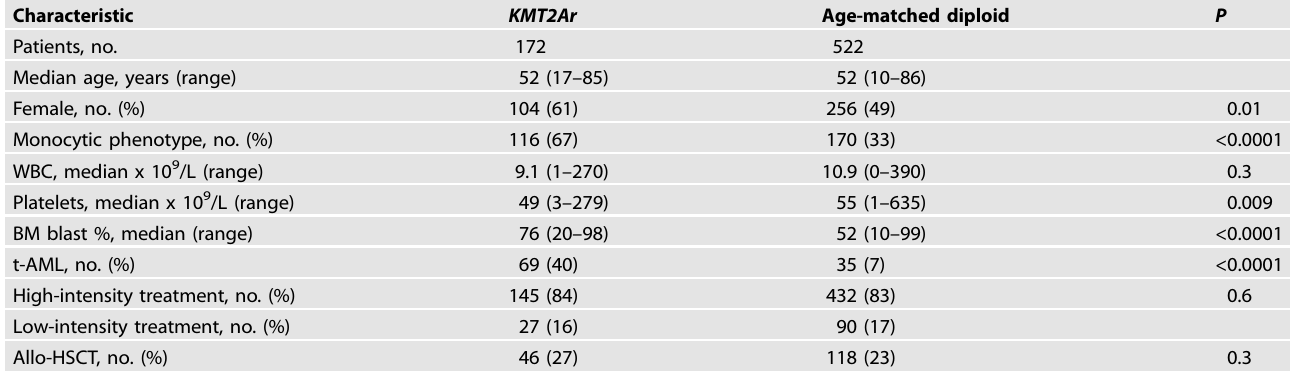
Table 1. Baseline characteristics of newly diagnosed adults with AML.